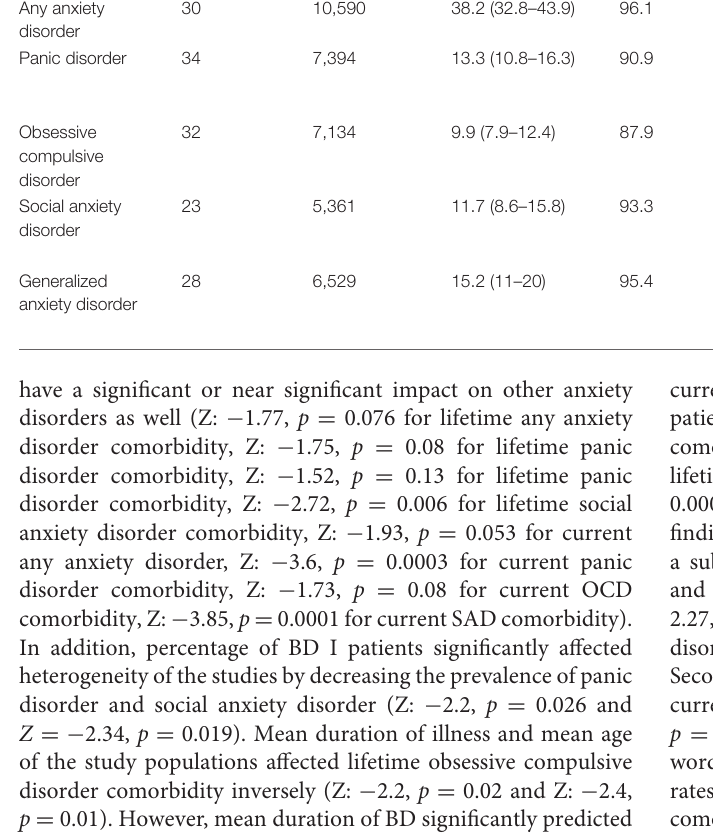
TABLE 2 | Current comorbidity of anxiety disorders in bipolar disorder. Current